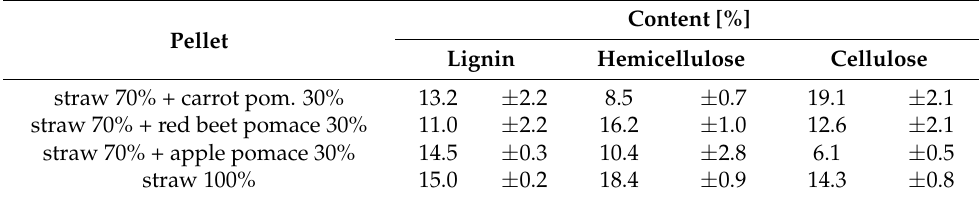
Table 4. Lignin, hemicellulose and cellulose content determined in pellets.